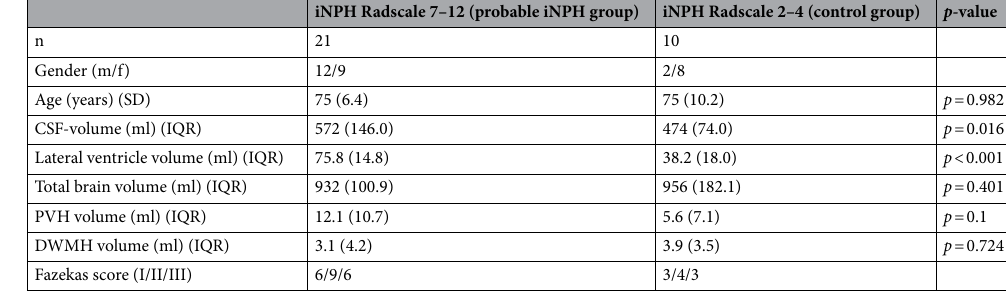
Table 1. Patient and imaging characteristics. CSF = cerebrospinal fluid, DMI = diffusion microstructure imaging, DWMH = deep white matter hyperintensities, iNPH = idiopathic normal pressure hydrocephalus, PVH = periventricular hyperintensities. Values are given in mean and SD or median and interquartile ranges (IQR).